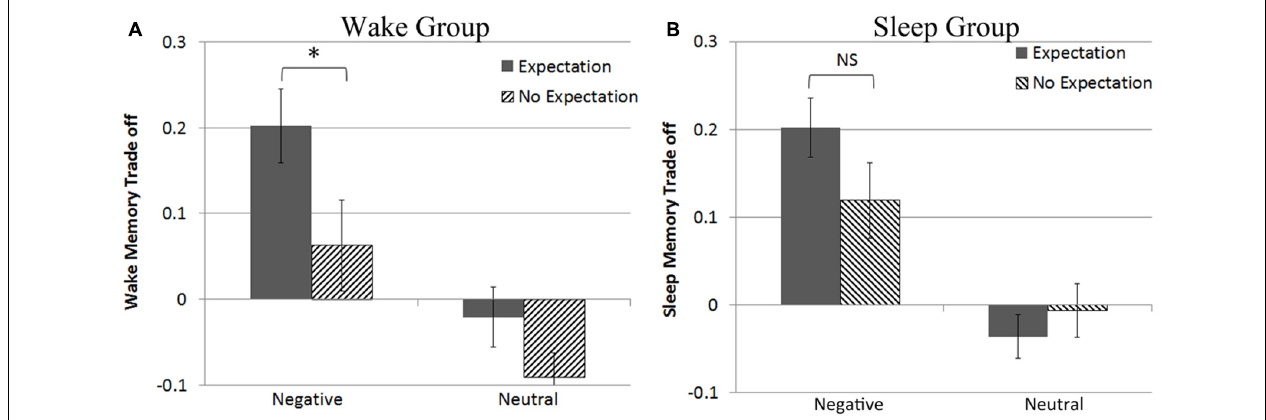
FIGURE 3 | (A) Expectation increases negative memory trade-off in the wake group (B) but has no effect after a delay of sleep. * p < 0.05.